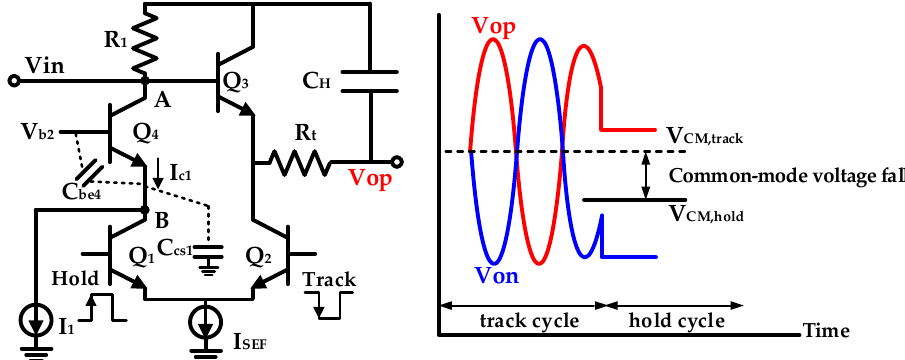
Figure 4. Common-mode voltage fall during the track-to-hold transition.